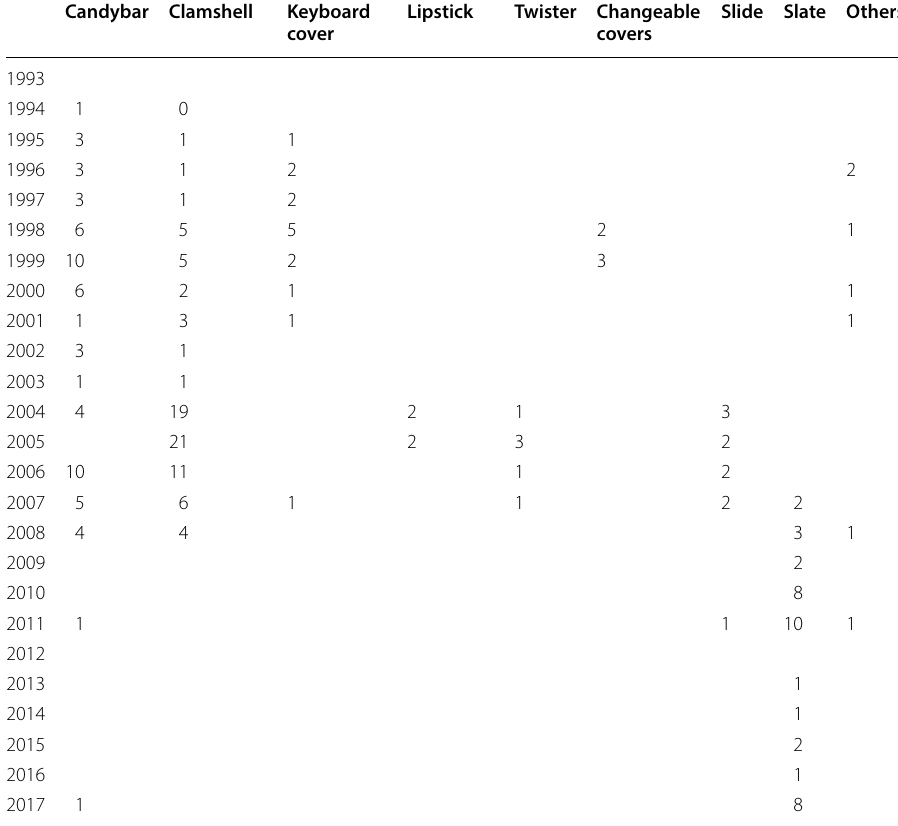
Table 2 The numbers of the occurrences of different forms in fashion magazines between 1993 and 2017 Candybar Clamshell Keyboard Lipstick Twister Changeable Slide Slate cover covers